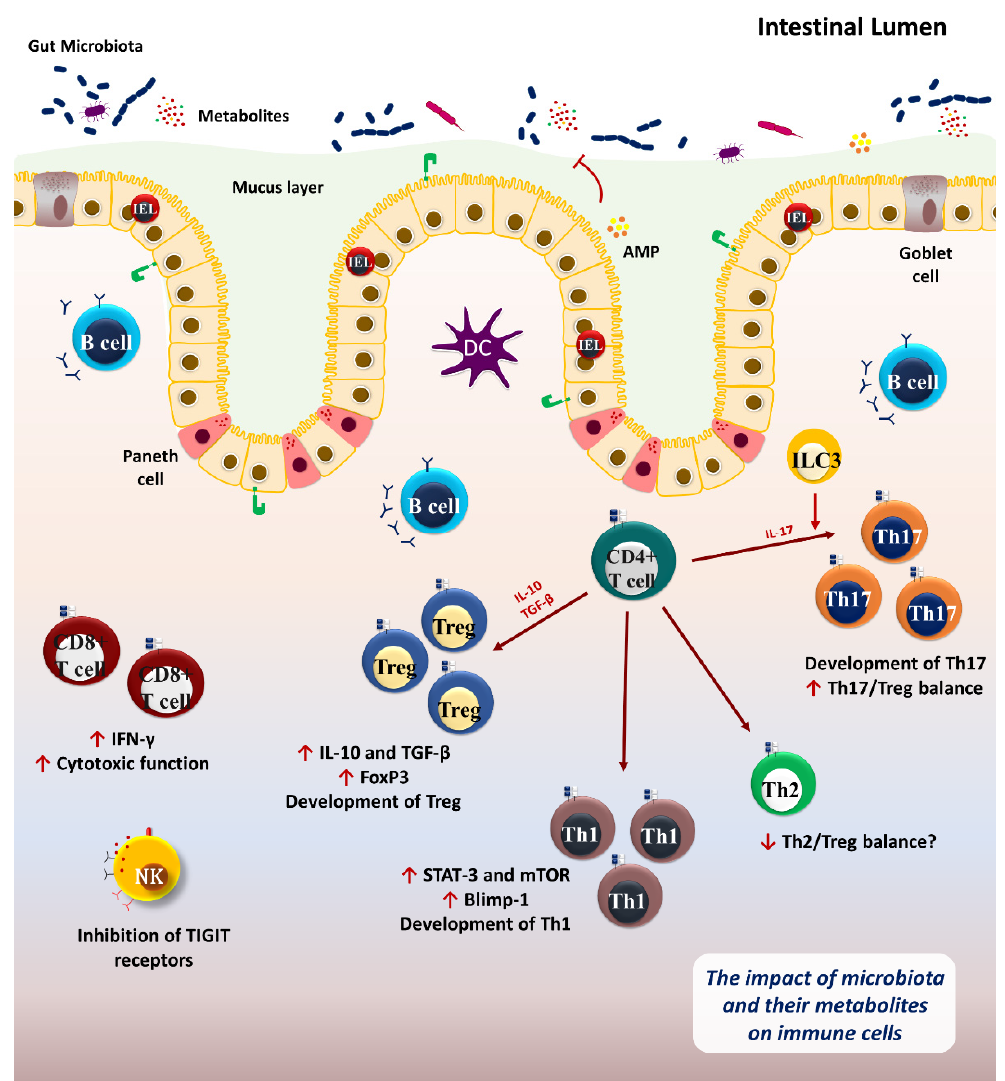
Figure 1. The interaction between gut microbiota and the immune system. The intestinal microbiota and their metabolites, including SCFAs, induce T-cell differentiation mainly on Tregs, Th1, and Th17 cells, impacting systemic immunity. The gut microbiota orchestrates Th1 differentiation from CD4 + T-cell by induction of STAT-3 and mTOR pathway. In addition, microbiota induces Treg development by the production of IL-10 and TGF- β . Microbiota and their metabolites may increase the Th17/Treg balance. The intestinal microbiota could activate CD8 + T-cells and NK cells which are critical in anti-tumor immunity. On the other hand, the immune system modulates systemic microbial translocation and inflammation through the activation of PRR signaling pathways as well as the production of AMPs. IEL: intraepithelial lymphocytes; PRR: pattern recognition receptor; AMP: antimicrobial peptides; DC: dendritic cell; NK: natural killer cell; ILC3: Type 3 innate lymphoid cells; TIGIT: T-cell immunoglobulin and ITIM domain.